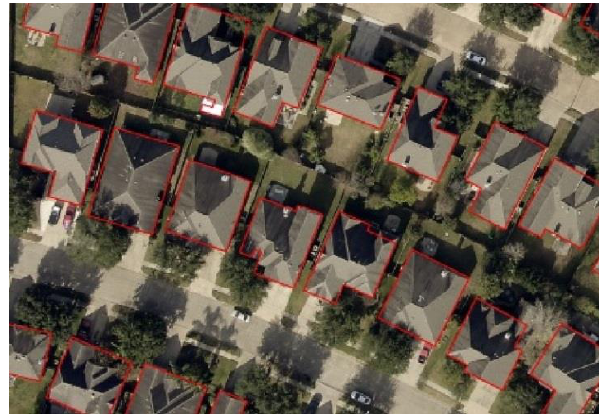
Figure 10 Extracted Building Outlines in Partial Occluded